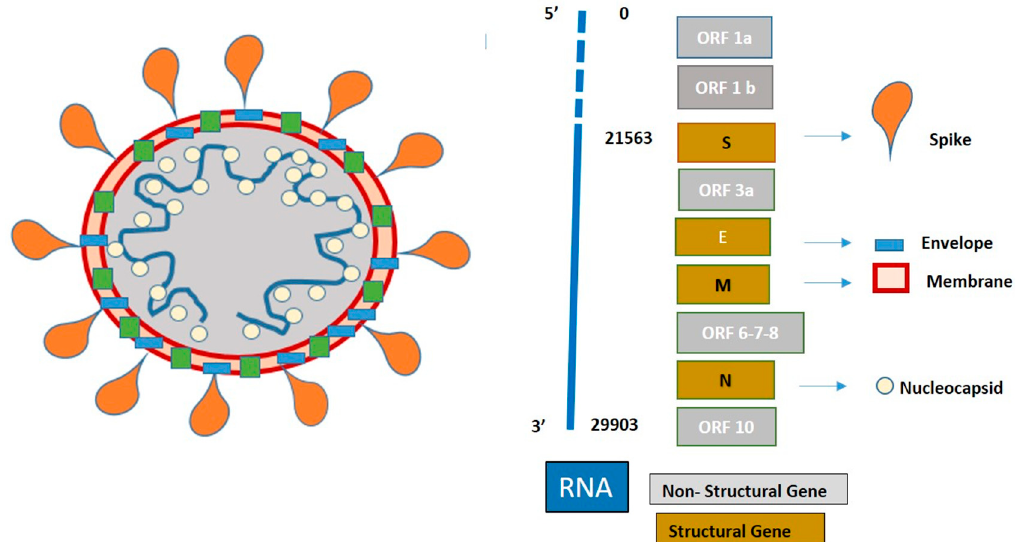
Figure 1. Schematic representation of severe acute respiratory syndrome coronavirus 2 (SARS-CoV-2) structure and ge- nomic.